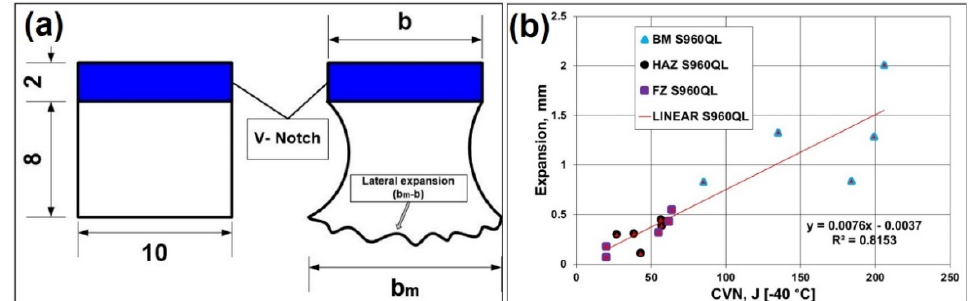
Figure 15. ( a ) Lateral expansion on CVN test specimen (all dimensions in mm) data from [44]; ( b ) Expansion graph.